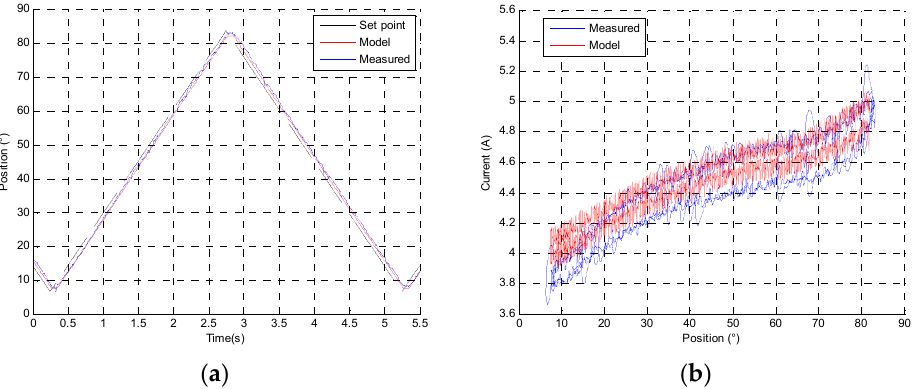
Figure 17. ( a ) Increasing and decreasing slope response comparison between measure and direct drive numerical model; ( b ) Current response comparison at 12 V and 25 °C conditions.